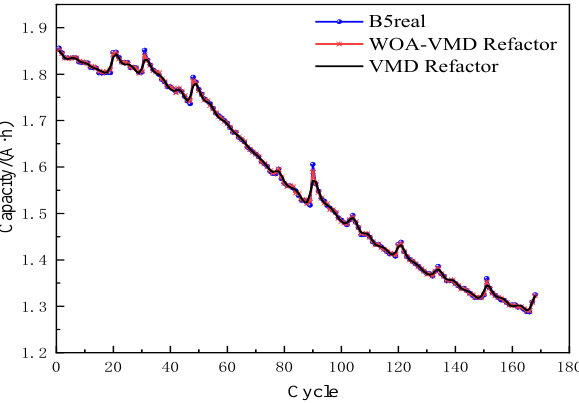
Figure 10. Comparison of the WOA-VMD and VMD reconstruction.